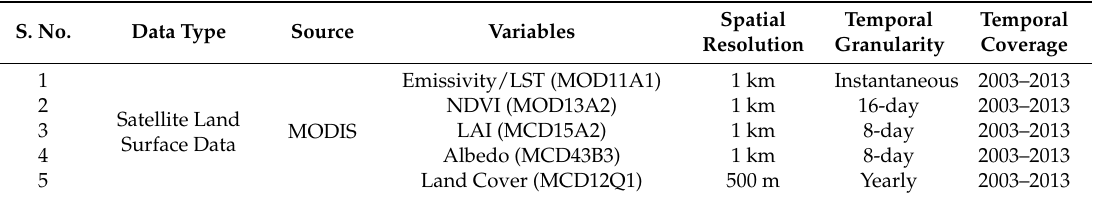
Table 2. Characteristics of the Moderate Resolution Imaging Spectroradiometer (MODIS) products used in the estimation of ET a for a period (2003–2013) across the Kabul River Basin. S. No. Data Type Source Variables